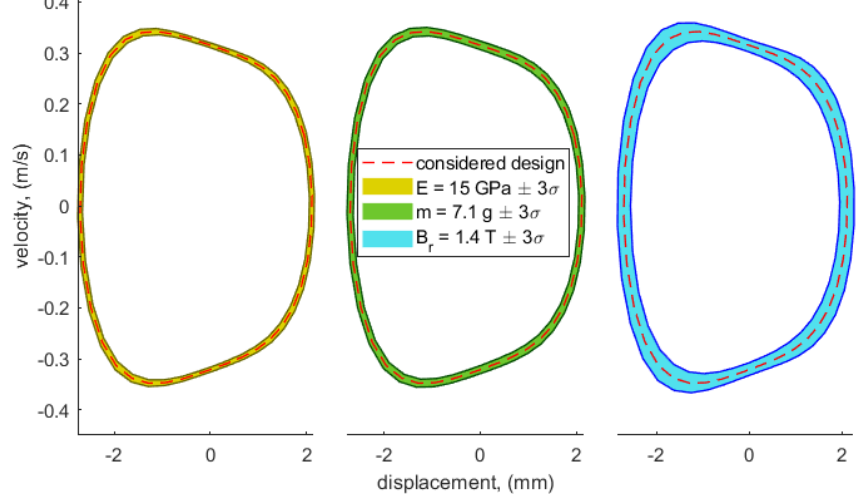
Figure 6. Poincare maps of the centre of mass of a vibrating yoke obtained for three border values of E , m , and B r (see Table 2). The results are obtained from model (20) for sinusoidal acceleration with a RMS = 12.5 m/s 2 and frequency equal to 25 Hz.